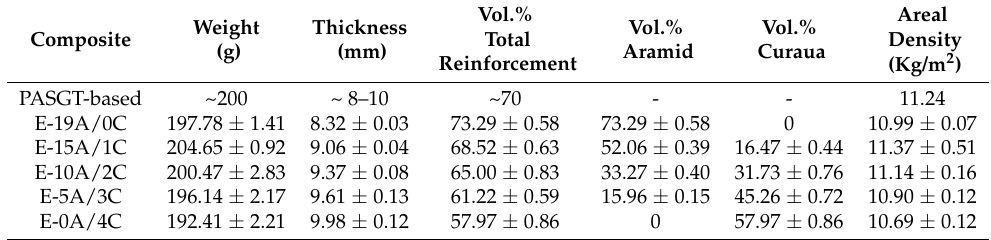
Table 3. Composite’s parameters associated with distinct configuration